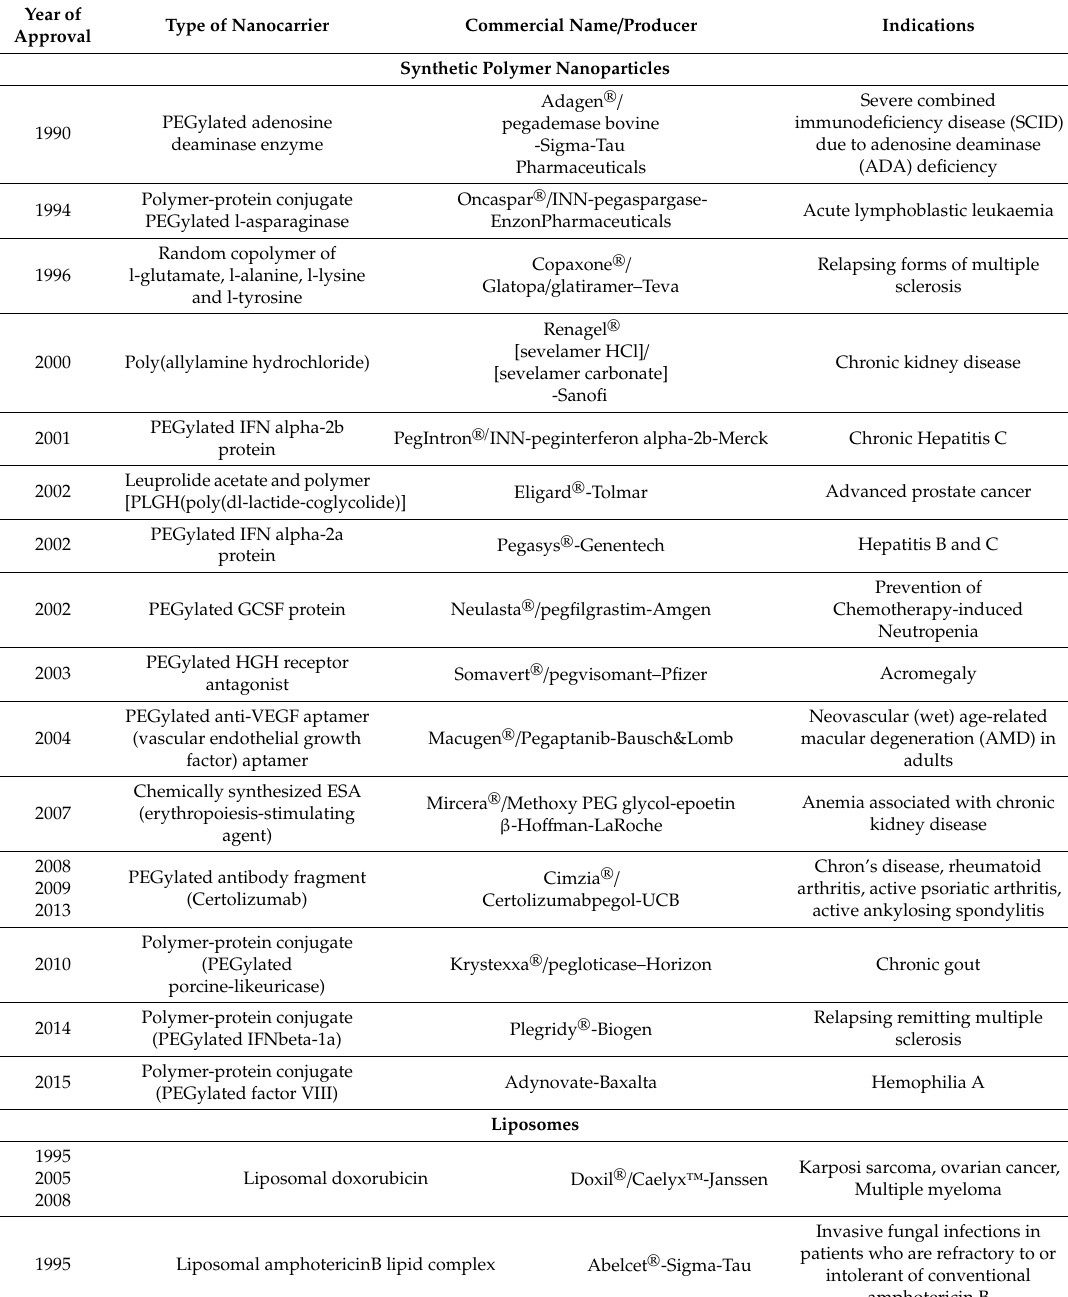
Table 1. Currently approved nanomedicines in clinical